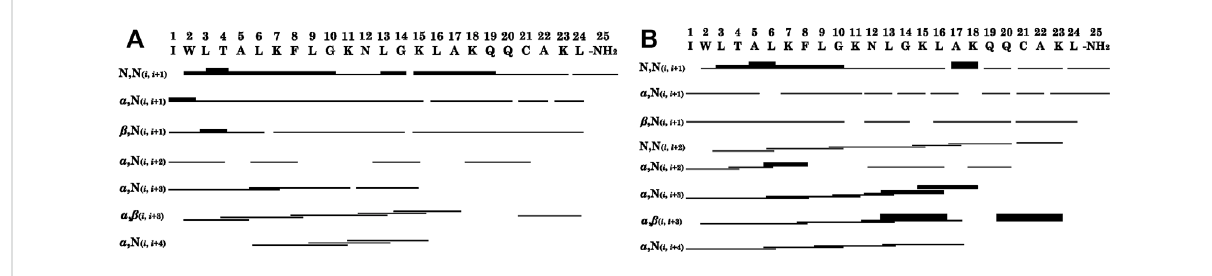
GraphicalsummaryofNOEcorrelationscharacteristicof α -helicalstructuresobservedinNOESYcontourmapsof (A) LyeTxI-b cys and (B) LyeTx I-bPEG.Thin,mediumandthickbarsrepresentweak,mediumandstrongNOEcorrelations,respectively.NH